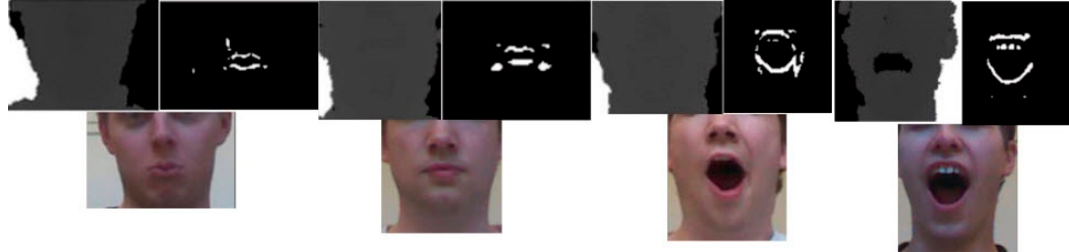
Figure 5. Segmented results that relies on having a clean binary image mouth by applying the adaptive mask on the depth image (first row) for 4 different individuals (second